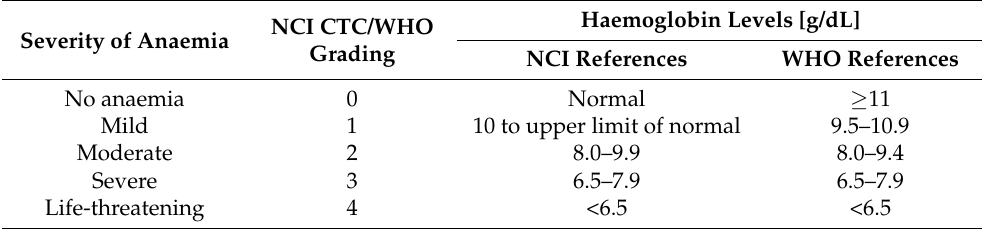
Table 1. Definition of anaemia and its severity according to WHO/NCI